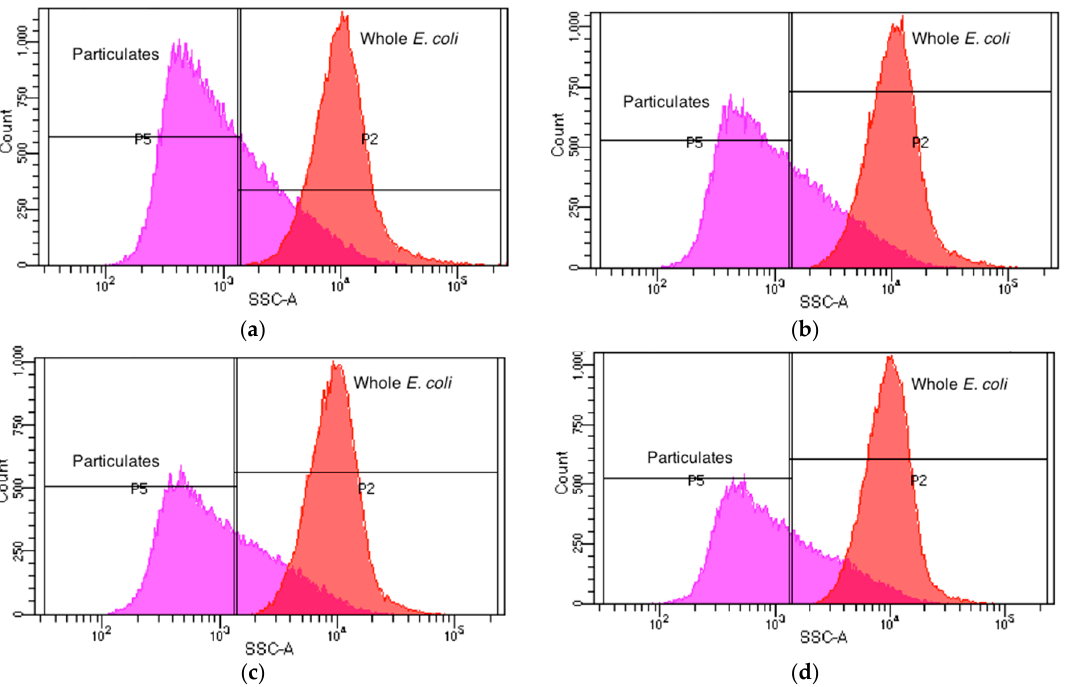
Figure 5. Population side scatter distribution for each sample tested. In each plot, the curve labeled “Whole E. coli ” corresponds to the side scatter distribution of whole E. coli cells, while the curve labeled “Particulates” corresponds to debris and other particulates that are not whole E. coli cells. ( a ) Side scatter distribution for the original sample which did not undergo treatment with the UV-C lamp; ( b ) Side Scatter distribution for a sample which underwent 15 min treatment with the UV-C lamp; ( c ) Side scatter distribution for a sample which underwent 1 min treatment with the UV-C lamp; ( d ) Side scatter distribution for a sample which underwent 5 min treatment with the ER.